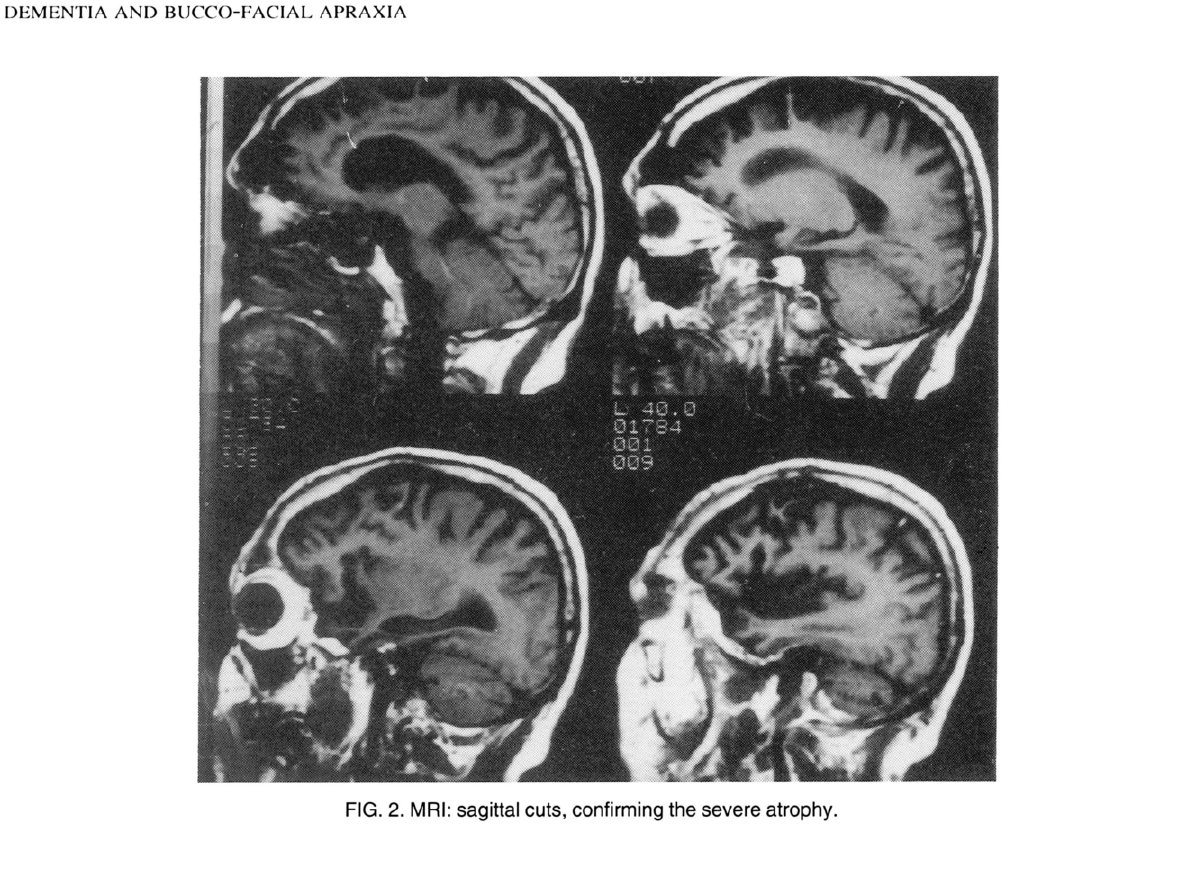
FIG. 2. MRI: sagittal cuts, confirming the severe